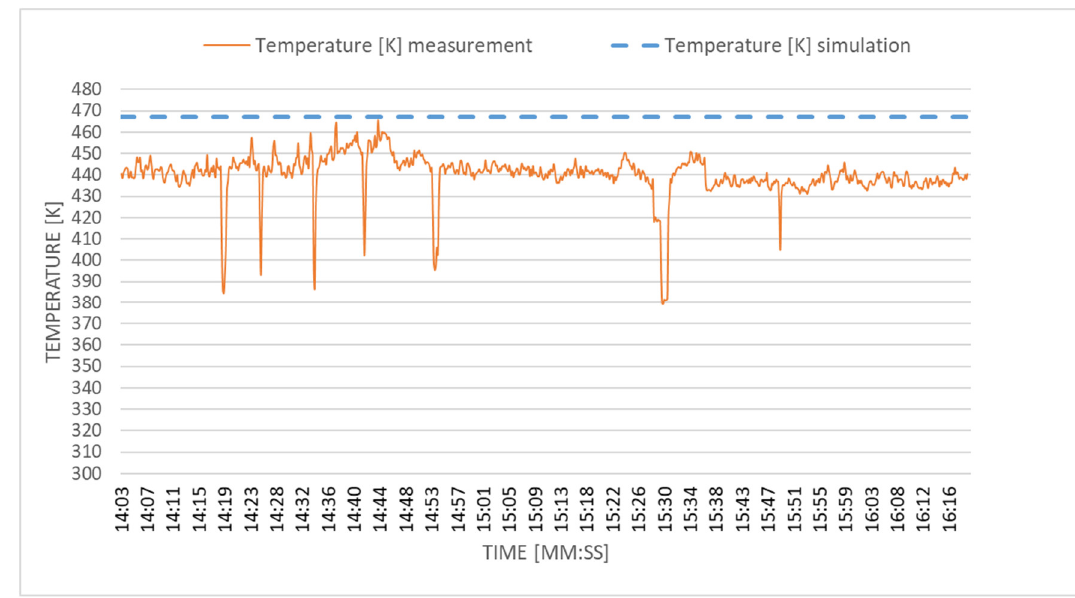
Figure 14. The measured value of the flue gas temperature in the chimney duct.